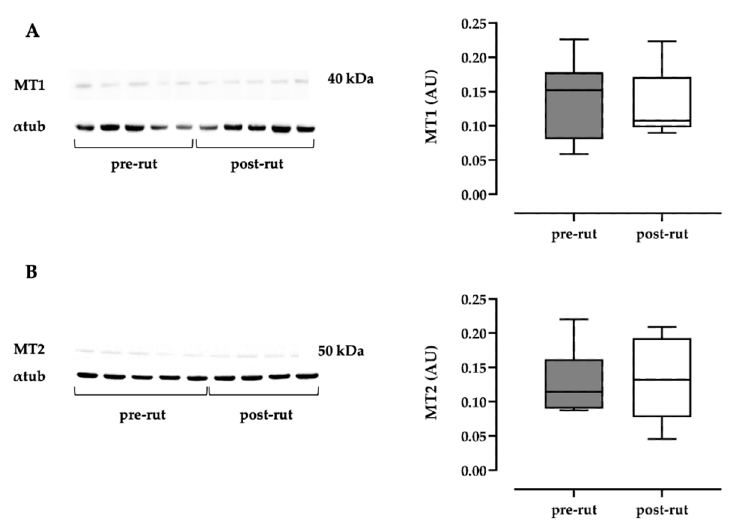
Figure 3. Western blot analyses and comparisons between pre- and post-rut periods for the melatonin receptors 1 ( A ) and 2 ( B ). α tub, alfa-tubulin; MWM, molecular weight markers. (original western blot figures in Figure S1).